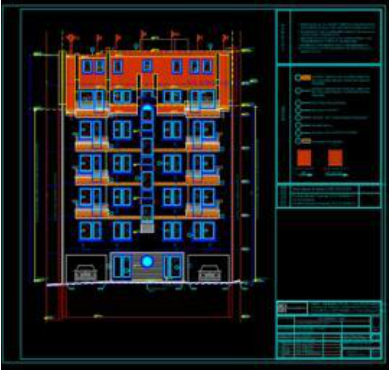
Figure 7. Architectural drawing.